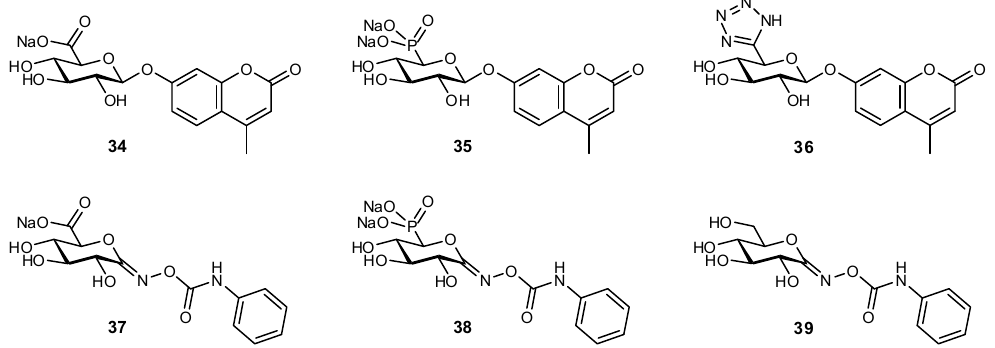
Figure 12. Phosphono and tetrazolyl derivatives of 4-methylumbelliferyl β - D -glucuronide were synthesized and evaluated as β -glucuronidase inhibitors. The phosphonate mimetics of the carboxylate displayed a very low level of activity, while the other mimetics were inactive [161] .